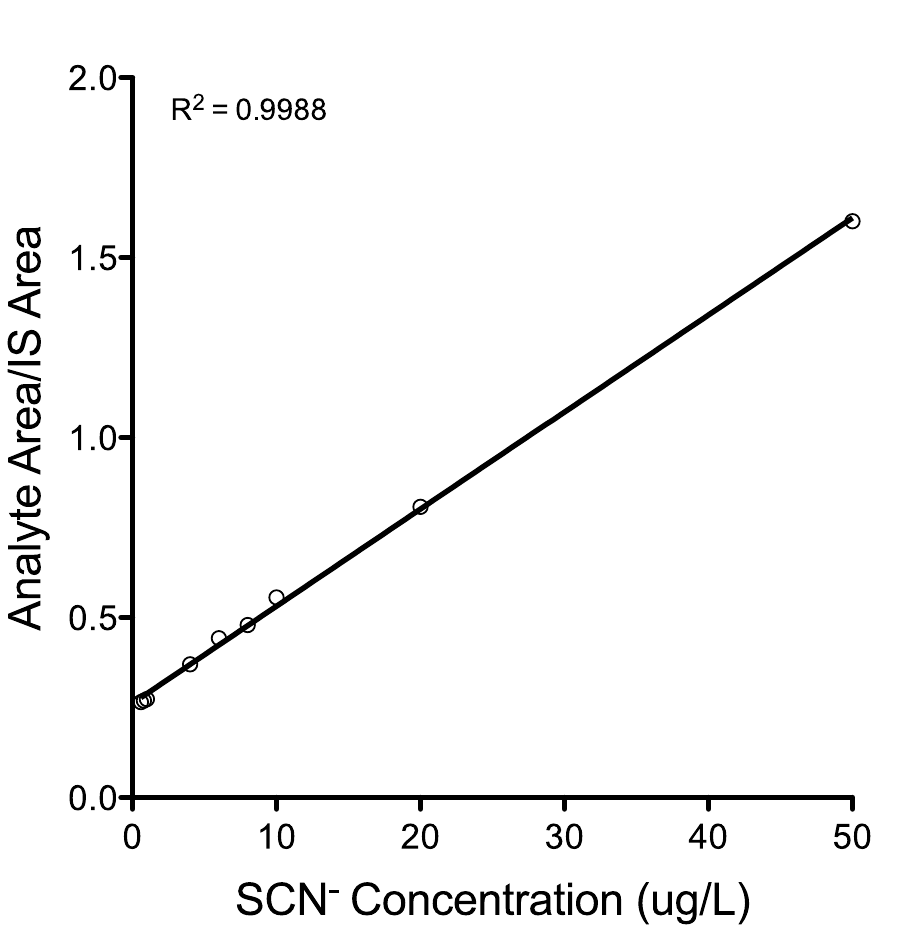
Fig 1. Typical standard curve of LC-MS/MS measurement of S13CN in